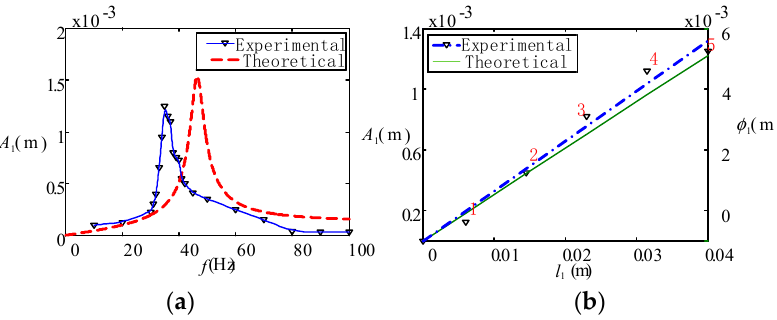
Figure 15. The 1st order modal experimental results of beam AB . ( a ) Frequency domain diagram of the 5th point on the beam AB ; ( b ) mode shape.